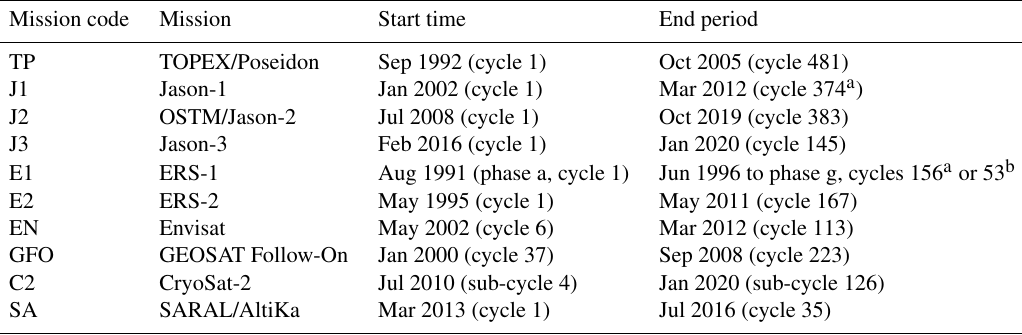
Table 4. Mission code used in the name of the GPD + datasets (Fernandes et al., 2019) and their availability. Mission